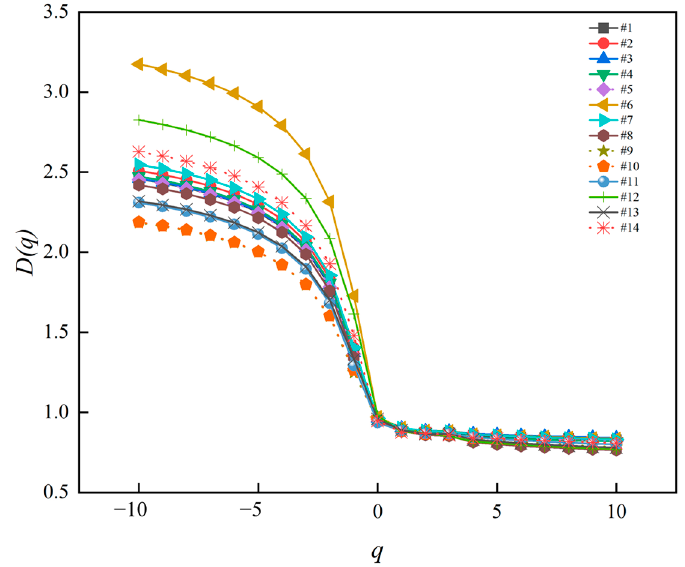
Figure 10. Relationship between D q and q (samples of solid lines were used to establish the model, samples of dotted lines were used to verify the model).